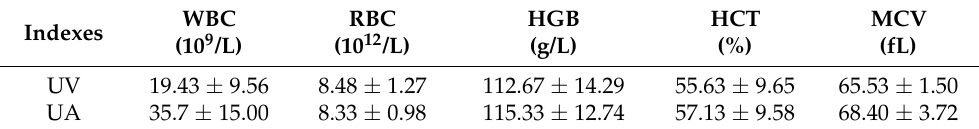
Figure 1. Characteristics of pig umbilical cord and its effect on birth weight. ( A ) Cross section of pig umbilical cord. ( B ) Diameters of pig umbilical cord (UC), umbilical vein (UV), and umbilical artery (UA). ( C ) Correlation analysis between pig umbilical cord diameter and newborn pig weight. N = 10. Table 1. Blood indexes of pig UVB and UAB.